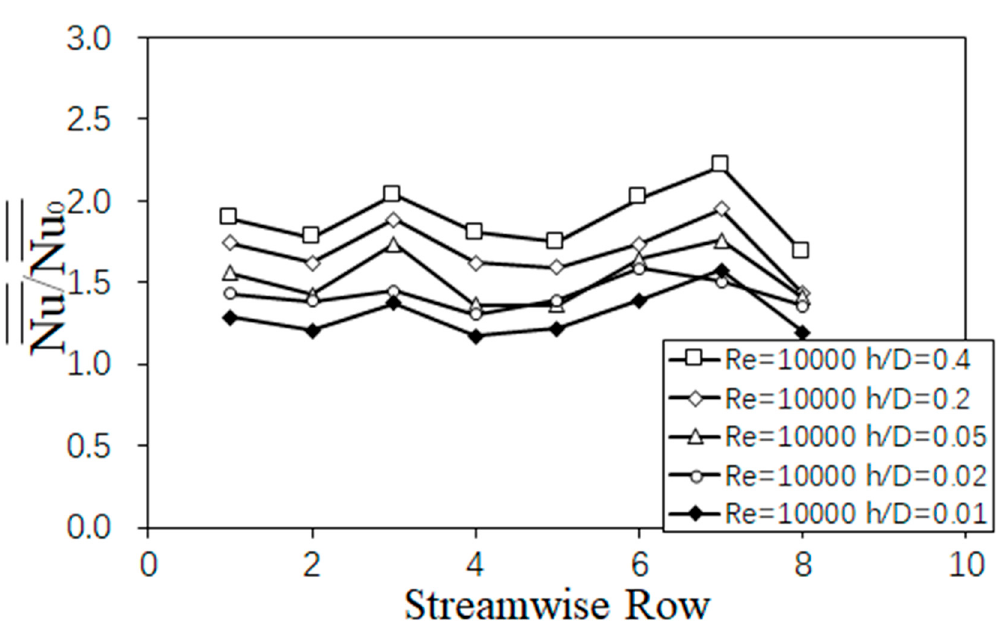
Figure 18. Spatially averaged Nusselt number ratios as dependent on streamwise row location, for micro cooling units height, for Re j =10,000.